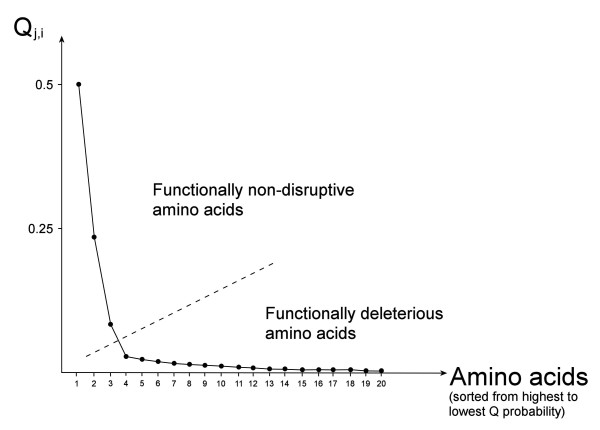
Scree plot of the probabilities Qj,i of each amino acid being present at position i. The probabilities are sorted from highest (left) to lowest (right). A fall contrast or scree criterium is applied to this plot to identify a cut point in the curve (dashed line), where the highest probability factors are chosen up to a point where the curve becomes approximately horizontal.